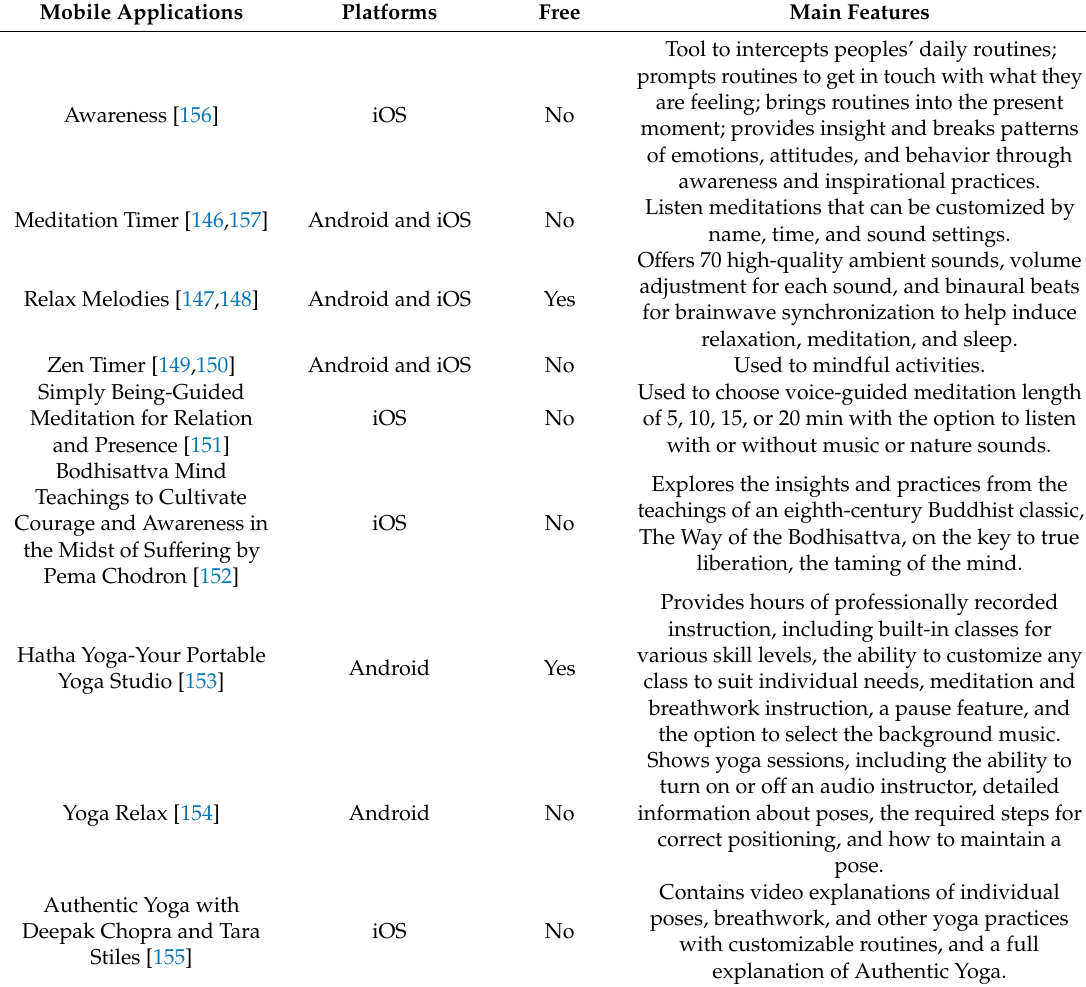
Table 4. Mobile health applications related to psychological